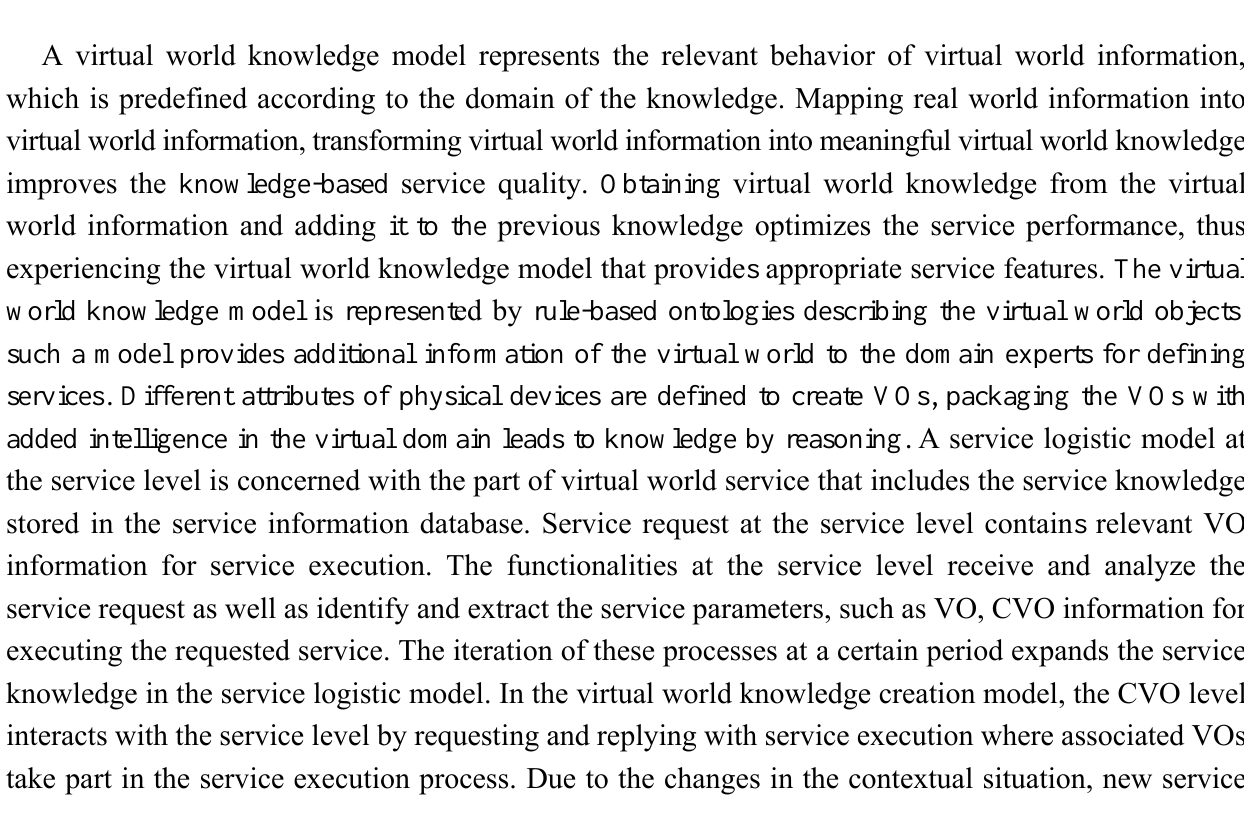
Figure 15. Virtual world knowledge creation model on WoO